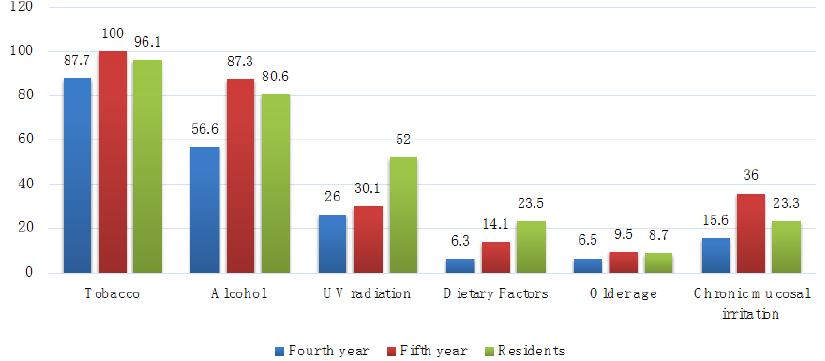
Figure 1. Percentage of participants that correctly identified the risk factors for oral cancer (Q2).